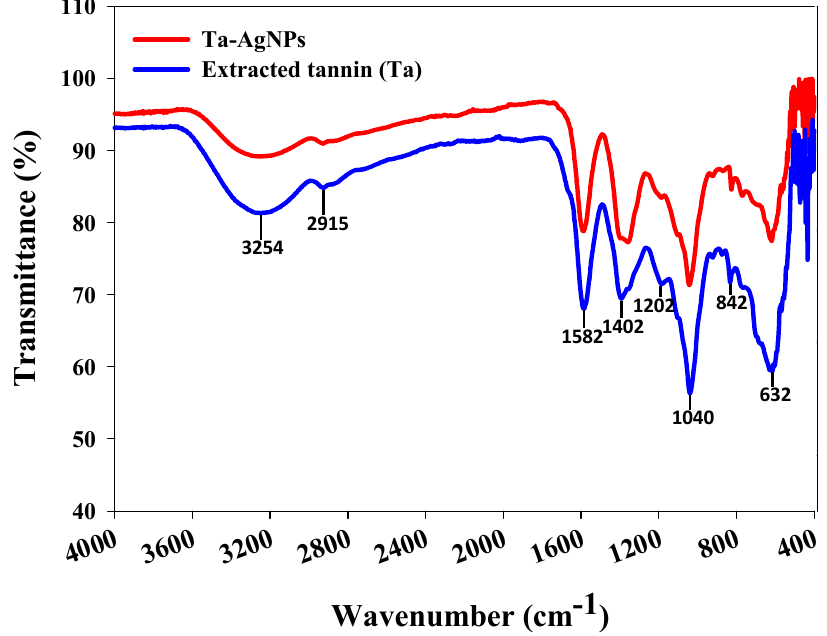
Figure 6. FTIR spectra of extracted tannin and Ta-AgNPs synthesized under optimized conditions.